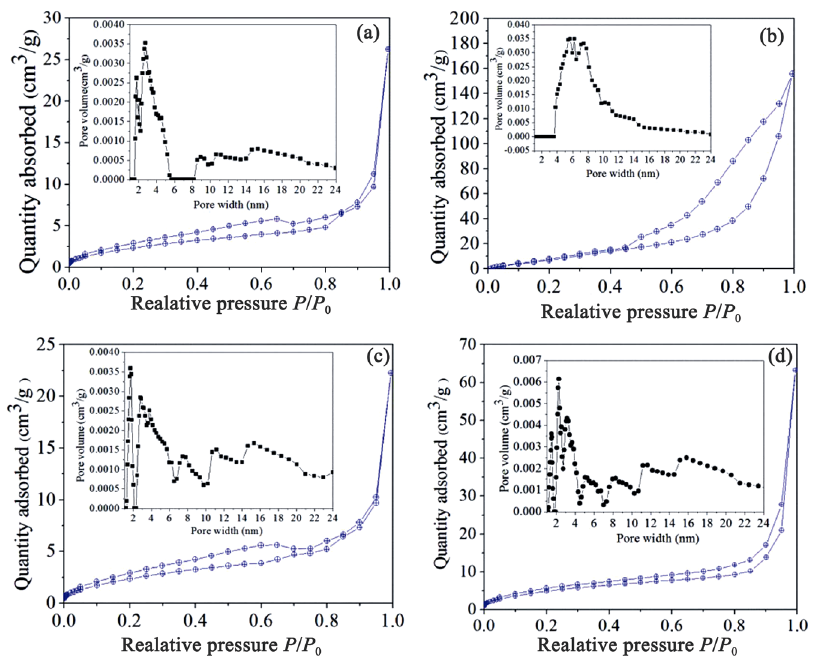
Fig. 5 N 2 sorption isotherms and pore size distributions of MXenes: (a) as-Ti 3 C 2 T x , (b) int-Ti 3 C 2 T x , (c) as-V 2 CT x , (d) int-V 2 CT x . volume is 0.25 cm 3 /g. The pore width of as-Ti 3 C 2 T x is